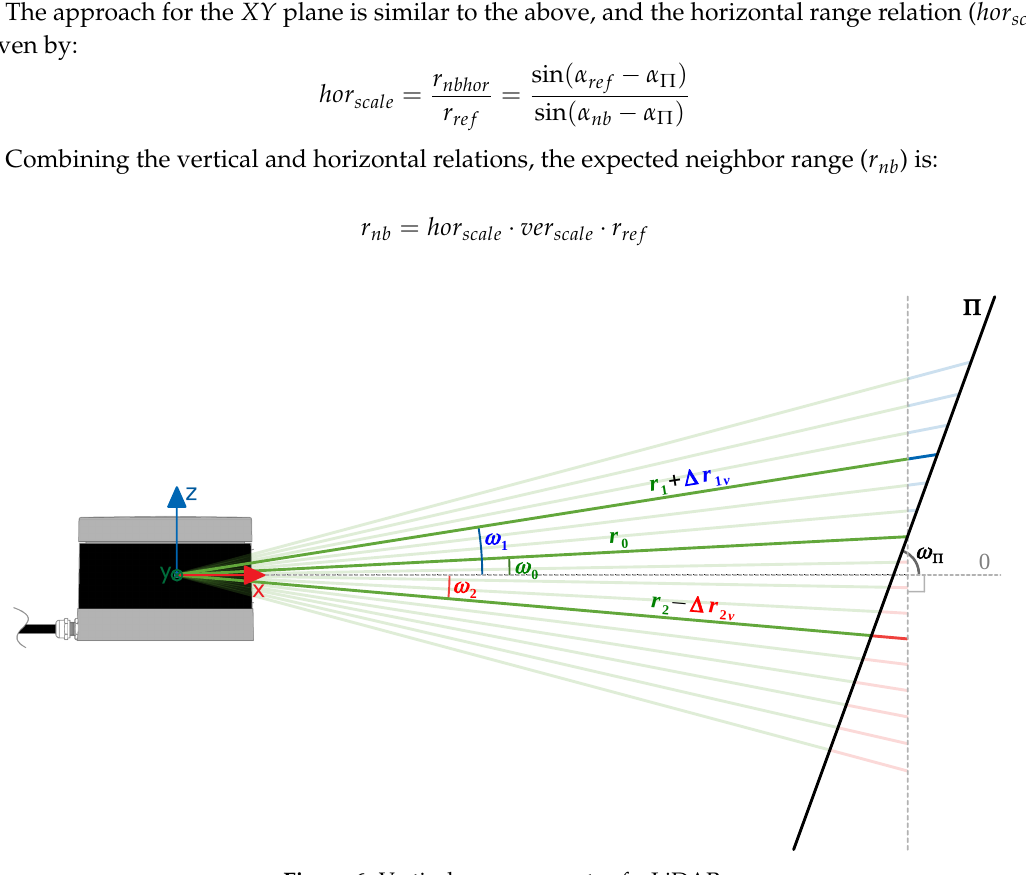
Figure 6. Vertical measurements of a